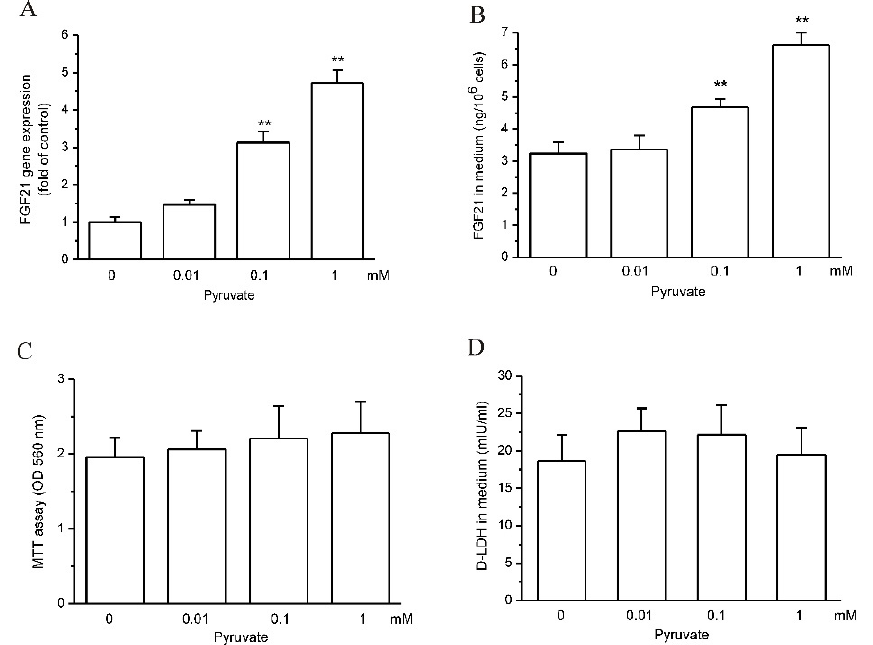
Figure 1. Pyruvate upregulated FGF21 expression and secretion in HepG2 cells. ( A ): pyruvate dose-dependently stimulated FGF21 gene expression after 12 h treatment in HepG2 cells (** p < 0.01 vs. control, n = 3). ( B ): FGF21 protein levels in cell medium significantly increased after pyruvate treatment (** p < 0.01 vs. control, n = 10). ( C ): The cell viability was not influenced by pyruvate treatment, as shown by MTT assay ( n = 10). ( D ): D-LDH levels in cell medium were not changed by pyruvate treatment ( n = 10).